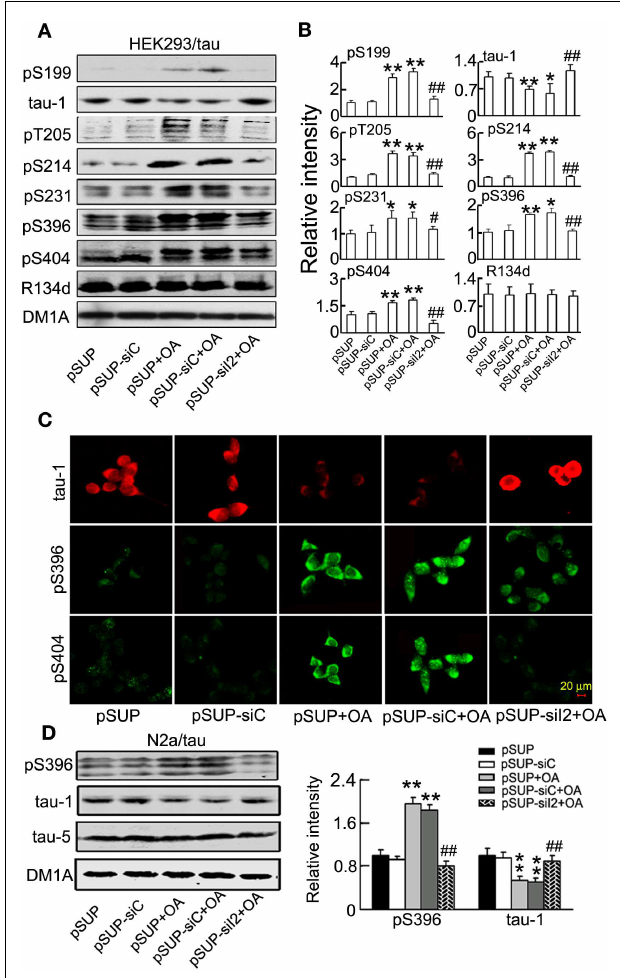
FIGURE 9 | siI PP2A attenuates tau hyperphosphorylation induced by 2 (pSUP-siI 2 ) okadaic acid in HEK293/tau or N2a/tau cells . pSUP - siI PP2A 2 was transfected into HEK293/tau (A–C) or N2a/tau cells (D) to knockdown the expression of I PP2A , and pSUP and pSUP-siC were expressed as the 2 controls. After 24h, OA (okadaic acid, 25nM) was administered for 24h. (A,B) The relative levels of hyperphosphorylated tau at Ser-199 (pS199), Ser-198/202 (tau-1),Thr-205 (pT205), Ser-214 (pS214),Thr-231 (pT231), Ser-396 (pS396), and Ser-404 (pS404) epitopes were detected byWestern blotting (A) and quantitative analysis (B) . (C) The phosphorylated levels of tau at Ser-198/202 (tau-1), Ser-396, and Ser-404 epitopes were detected by immunofluorescence staining. (D) The relative levels of hyperphosphorylation tau at Ser-198/202 (tau-1) and Ser-396 (pS396) epitopes were detected byWestern blotting and quantitative analysis.The relative intensity was normalized against total tau probed by R134d or tau-5 and expressed by setting pSUP as 1. DM1A serves as a loading control.The data were presented as mean ± SD of at least three independent experiments. * p < 0.05; ** p < 0.01 vs. pSUP; # p < 0.05; ## p < 0.01 vs. pSUP +